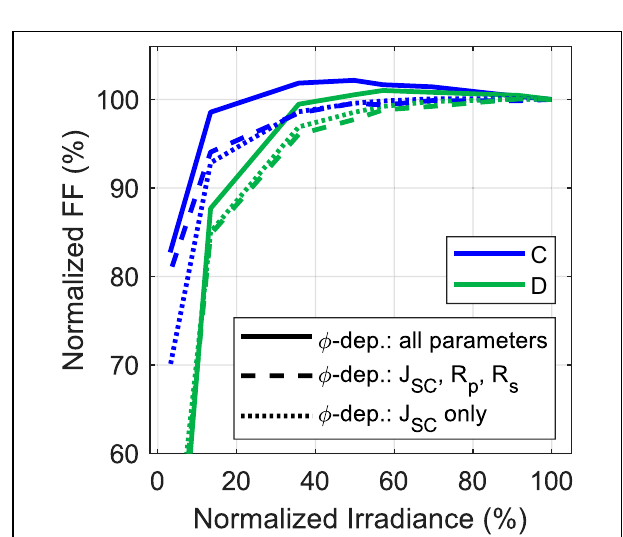
FIGURE 5 | Modelling the FF of cell types C (blue) and D (green) including the intensity dependence of either all parameters (solid lines), of J SC , R s and R p (dashed lines), or of J SC only (dotted